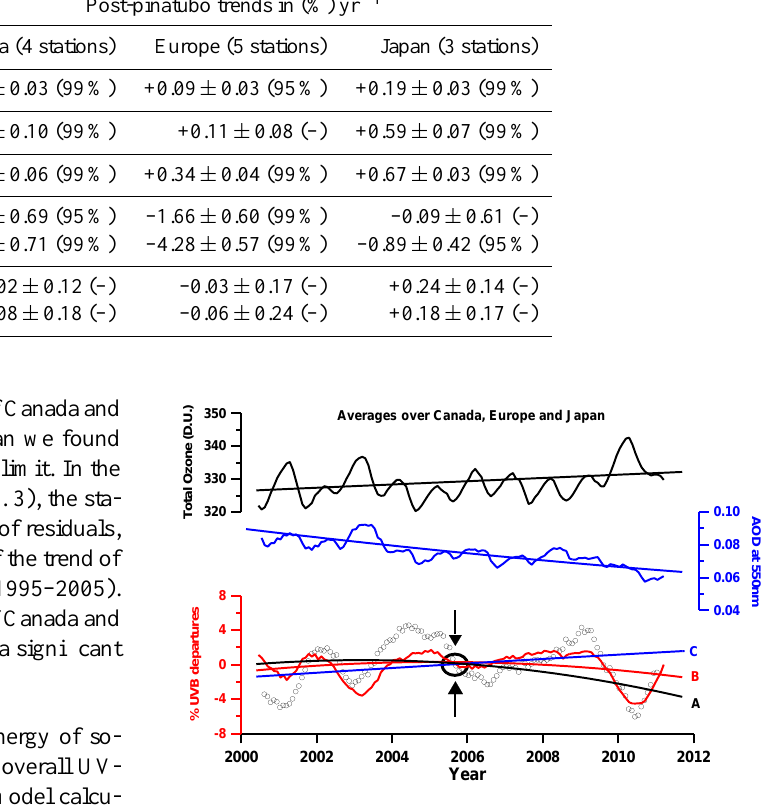
Fig. 4. Upper part: total ozone (12 month running mean) from ground-based measurements at 12 stations, Middle: average AOD from MODIS/Terra (12 month running mean) over the 12 stations. Lower part: 305nm irradiance departures (red) calculated with the RT model, and open circles are observed 305nm solar irradiances. Curves A, B, C are 2nd deg. polynomial fit of the calculated con- tribution of ozone (A), aerosol (C) and ozone and aerosol together (B) to the 305nm irradiance variation.